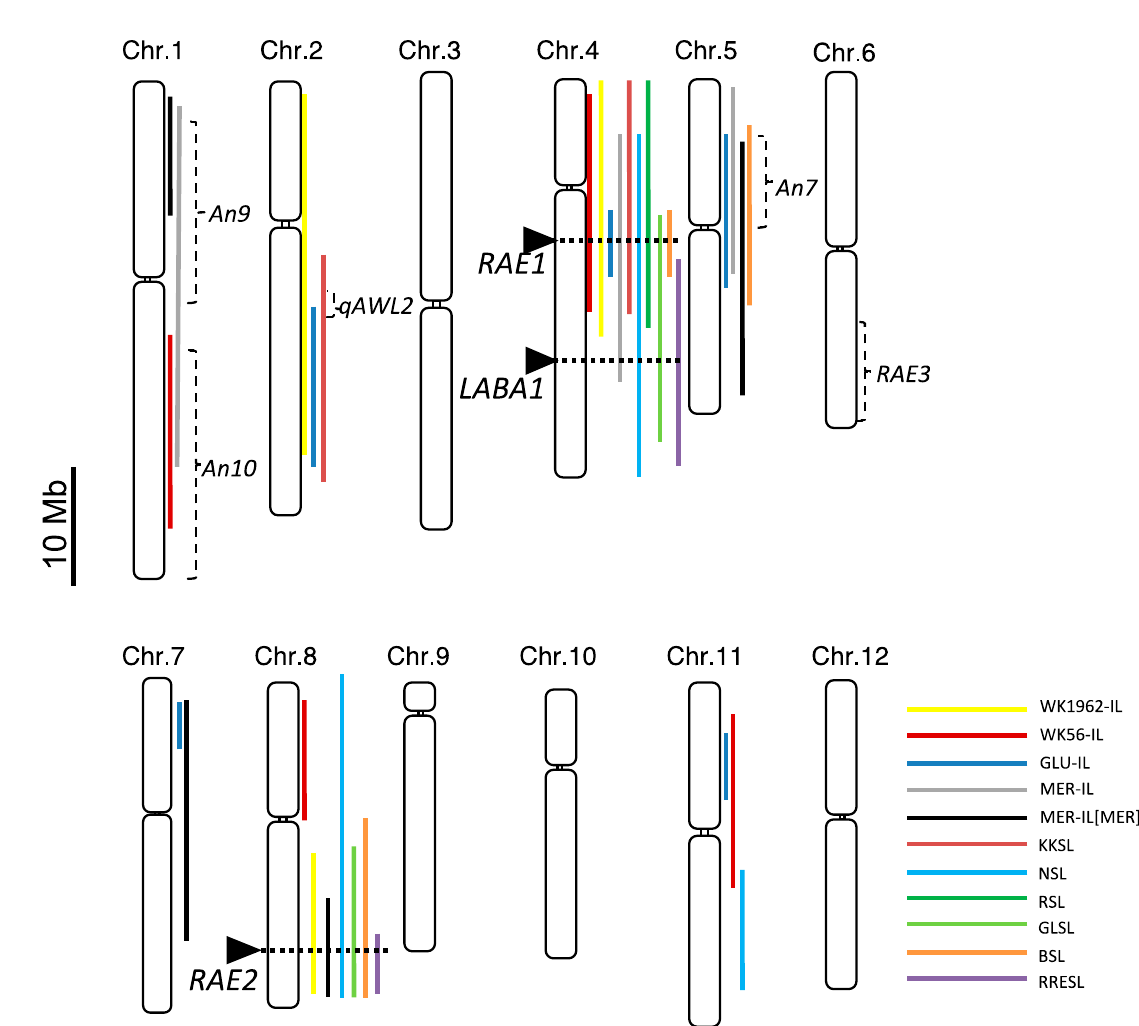
Figure 4. The responsible loci for awn development in each donor parent. White boxes indicate 12 rice chromosomes and the small box between big white boxes indicate centromere. Colored bars indicate the substituted chromosome region of the donor parent from each CSSL carrying the loci responsible for awn development. Black arrowheads indicate the positions of the genes RAE1 , LABA1 , and RAE2 . Dotted brackets indicate the loci of qAWL2 , An7 , An9 , An10 , and RAE3 previously identified through quantitative trait loci (QTL) or linkage mapping analysis.